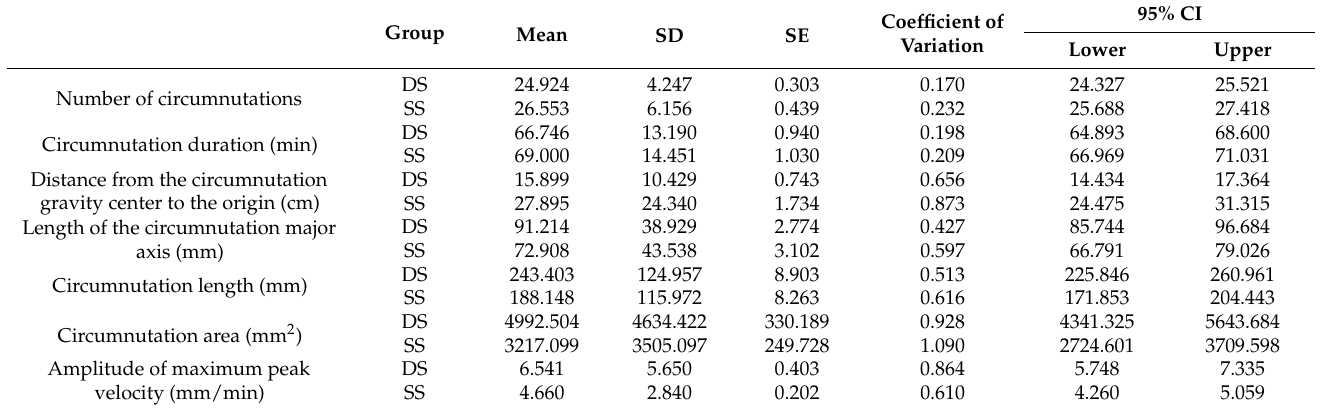
Table 1. Descriptive statistics for the considered dependent measures.